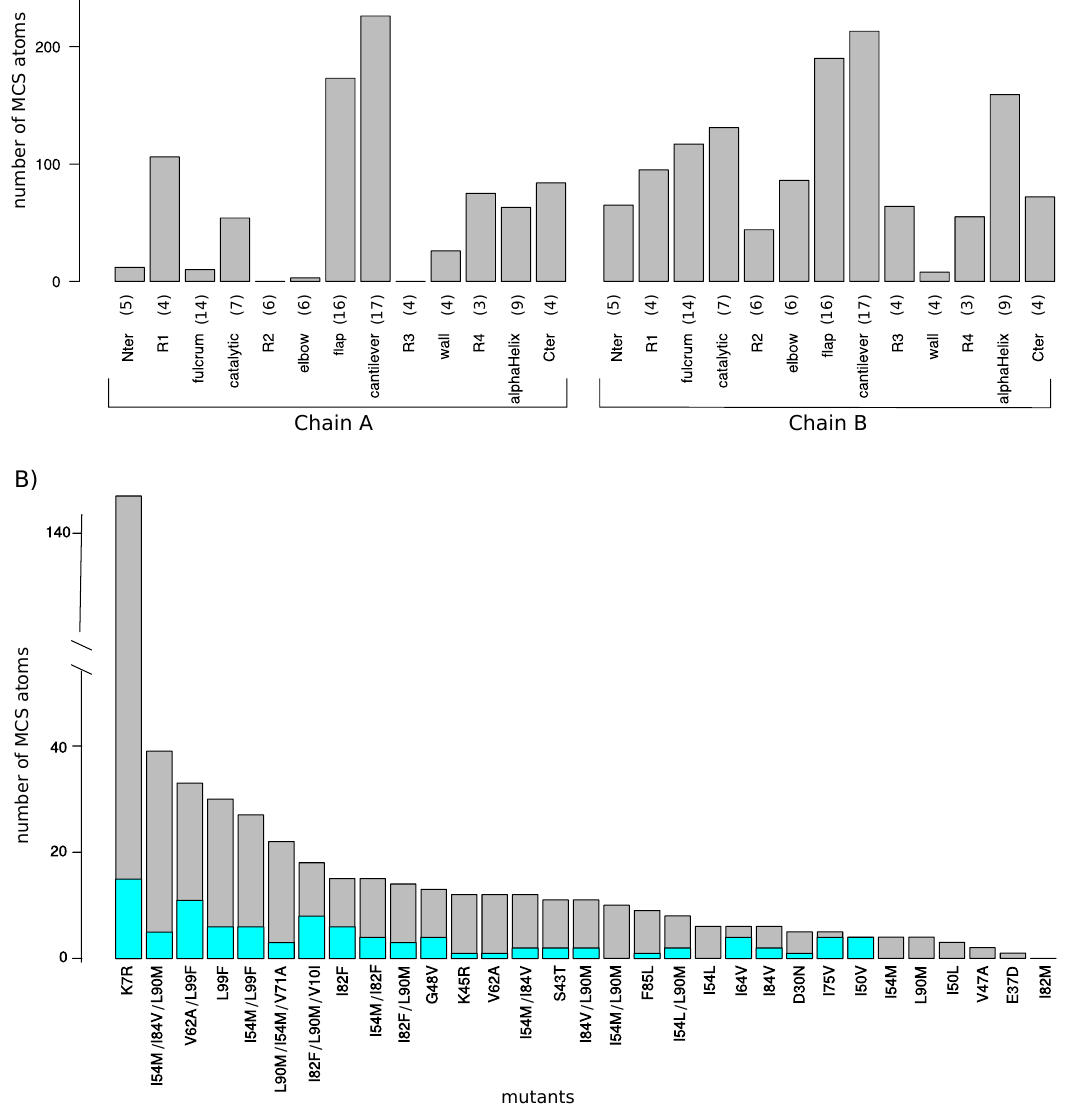
Figure 3. ( A ) Number of MCS atoms per mutant counted in the two PR2 chains. Each PR2 chain was divided in 13 regions according to [13]. Numbers in brackets indicate the size of each region in terms of amino acids. ( B ) Number of MCS atoms (grey) and MCS atoms with large magnitude ( dist WT − mutant ≥ 2 Å, cyan) per mutants. Mutants were sorted according to their number of MCS